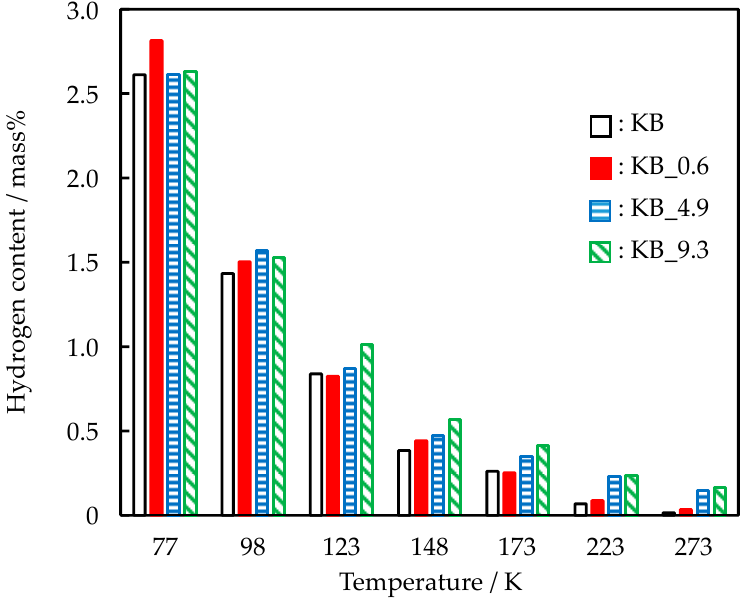
Figure 7. Variation of hydrogen content under 0.8 MPa of hydrogen with temperature for KB, KB_0.6, KB_4.9, and KB_9.3. The hydrogen contents at 273 K of KB and KB_0.6 are the saturated hydrogen contents under 0.38 MPa and 0.42 MPa of hydrogen, respectively.